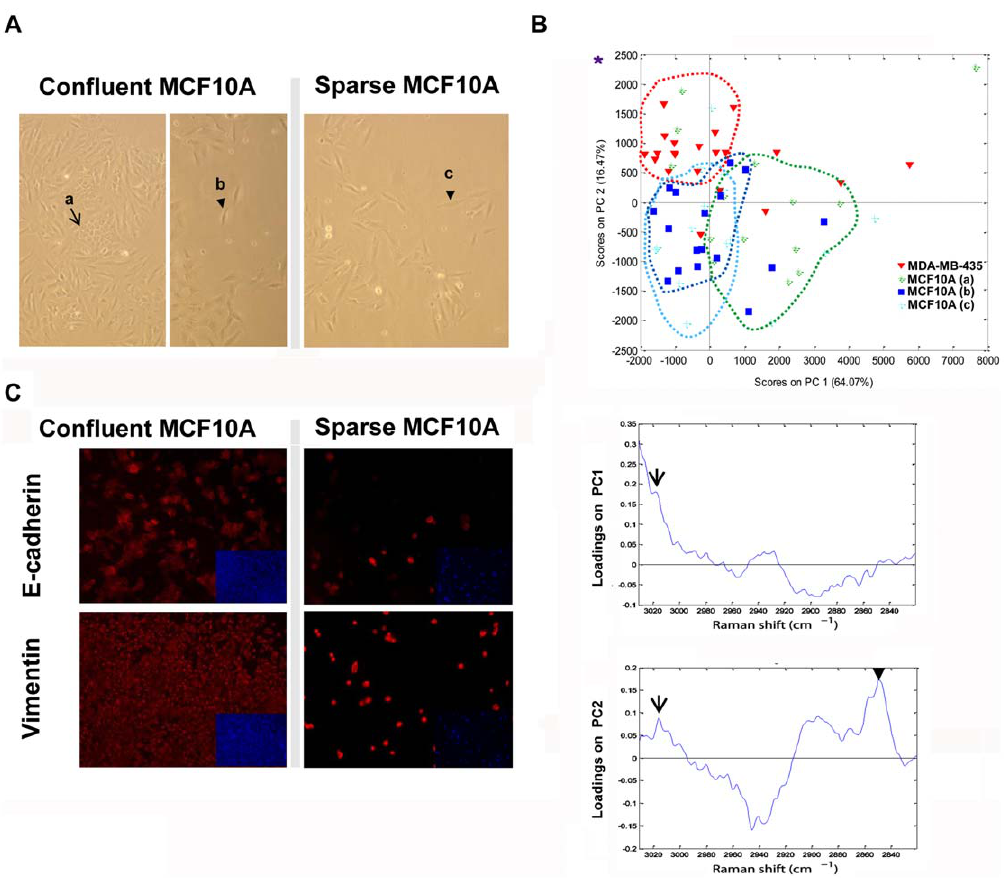
Figure 4. Raman microspectroscopy and PCA differentiate the MCF10A cells grown in confluent and sparse conditions. A) MCF10A microscopy images of the cells measured by RS in confluent and sparse conditions. Brightlight images were obtained with an inverted microscope and 10 6 magnification. Arrows indicate the different areas that were measured by Raman (a: confluent; b: separate cells grown at the edge of confluent cultures; c: sparse). B) PCA representation of MDA-MB-435 cells and MCF10A cells (grown in high confluence and in sparse conditions). PC 1 and 2 separate different groups of cell lines. MDA-MB-435 cells have higher PC2 scores, separated from the MCF10A. MCF10A grown in high confluence are displaced from the ones grown in sparse conditions showing higher PC1 scores. Asterisk indicates the localization of the ‘‘lipogenic phenotype’’ in the axis. PC1 and PC2 loadings are described down with the bands related to TFA (arrow head) and TUFA (arrow) indicated. The percentage means the variance accounted for each PC. C) Immunofluorescence images of E-cadherin and vimentin proteins in both MCF10A culture conditions. DAPI staining appears minimized inside each picture.